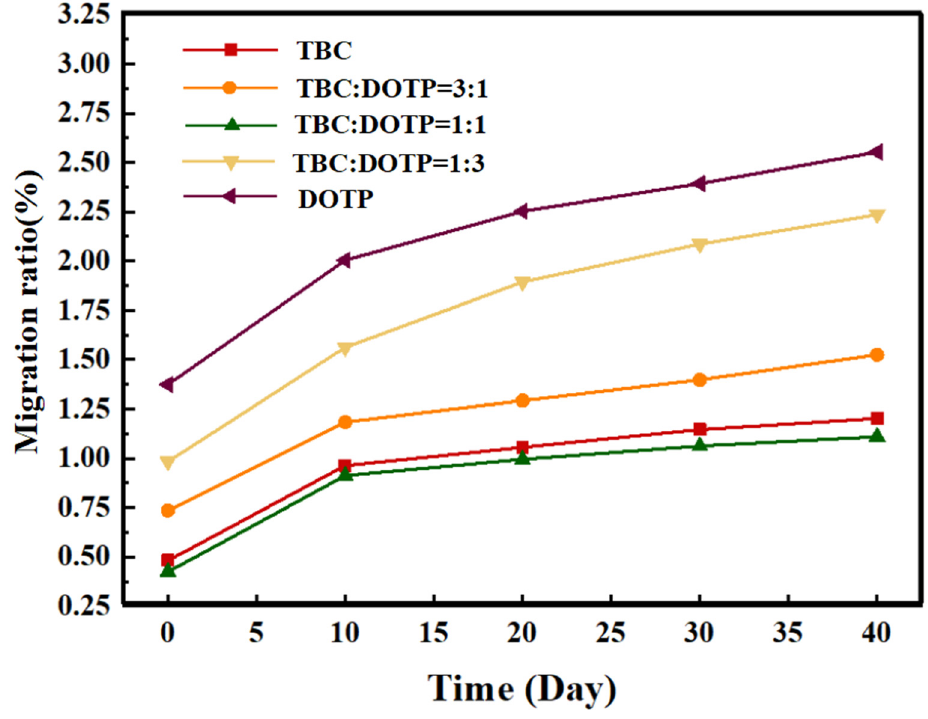
Figure 14. The migration ratio of Zn(Arg) 2 versus time in PVC with different proportions of TBC and DOTP.